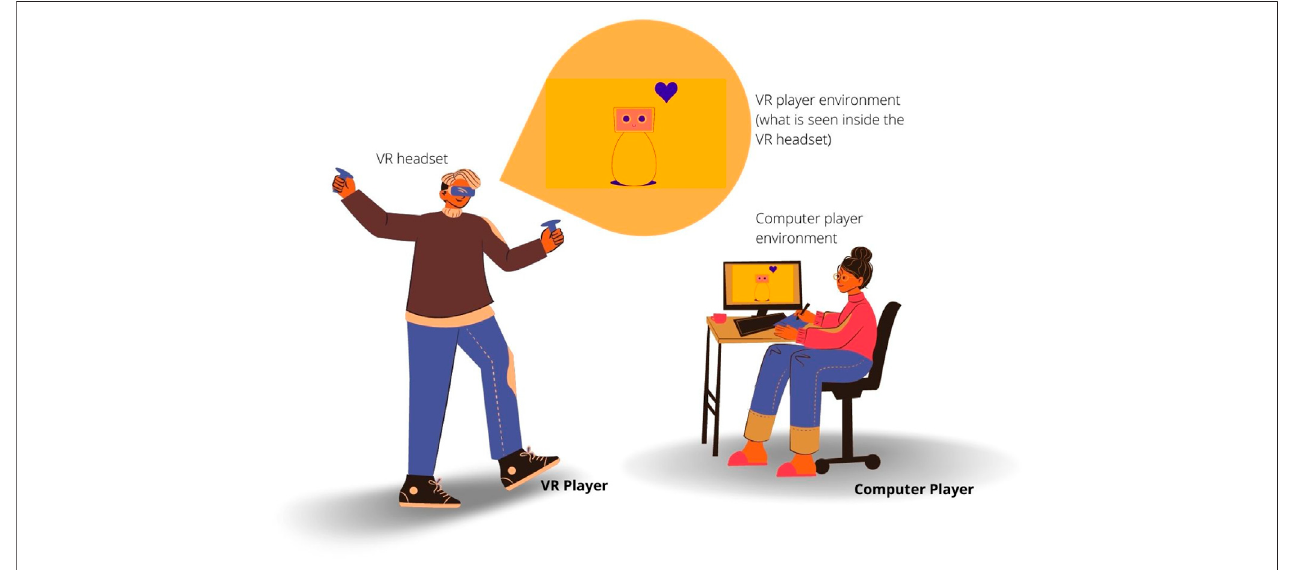
FIGURE 3 | Illustration of the asymmetric setup where each player has speci fi c abilities creating a forced, but enjoyable collaboration.